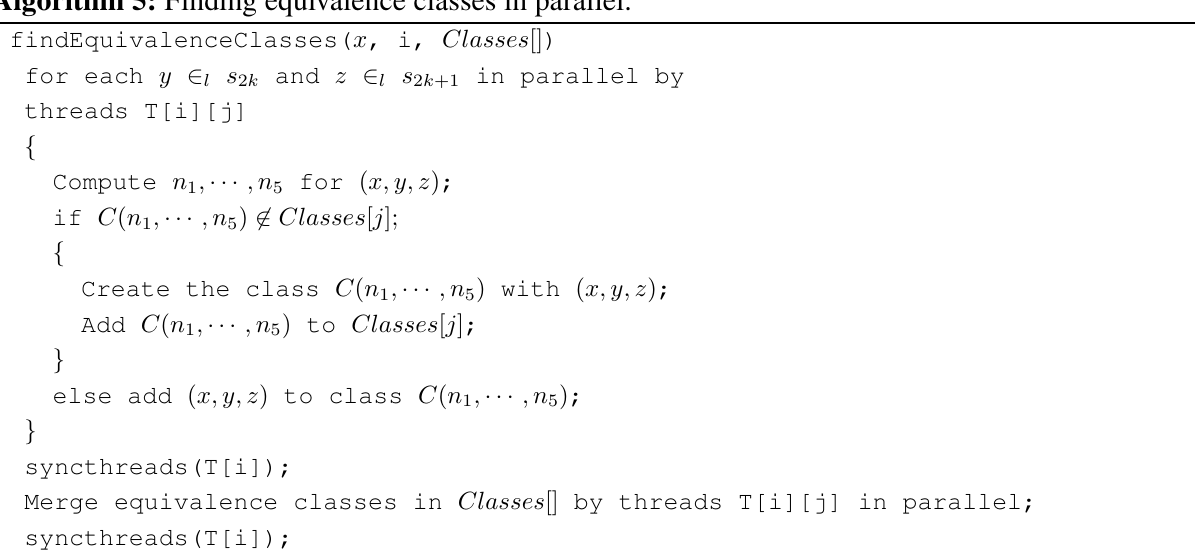
Algorithm 5: Finding equivalence classes in